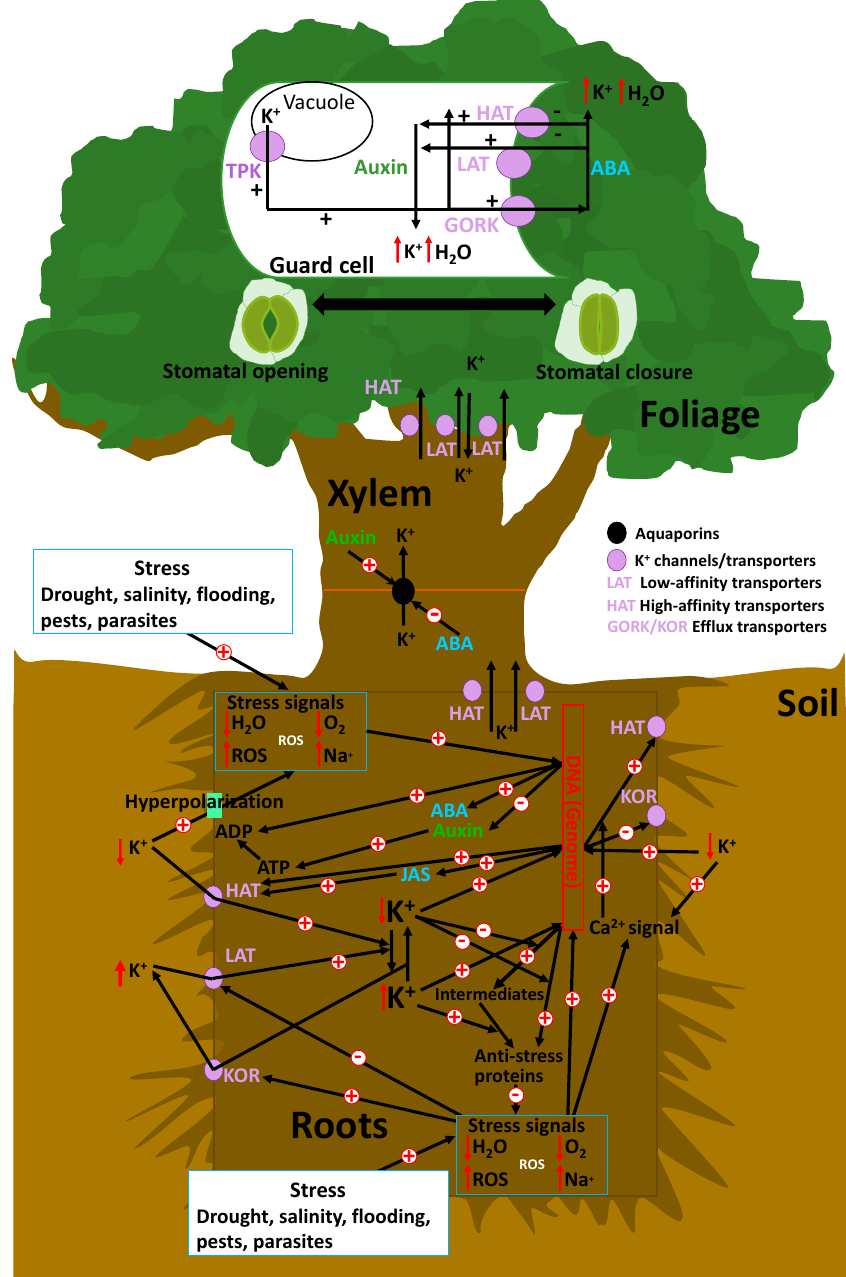
Figure 2. Schematic of the K + uptake and transport in plants, with special attention paid to the potassium battery. The main functions are depicted in green